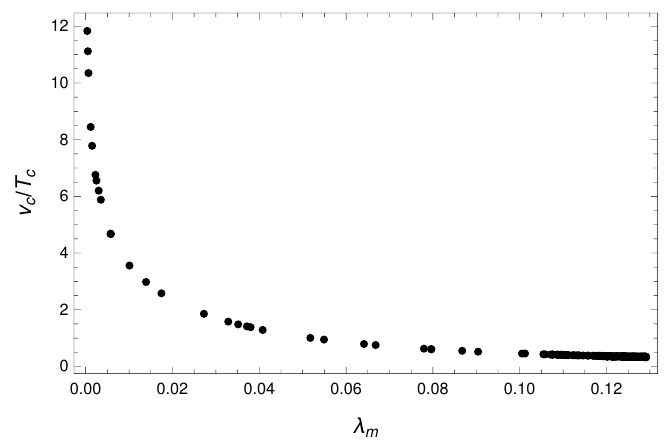
Figure 16 . Numerically computed v c /T c values as a function of λ m ≡ λ h − λ 2 agreement with the analytical expression (5.8), strong FOPTs, v values of λ , or equivalently, small values of the dark U(1) m matches with the one presented in ref.